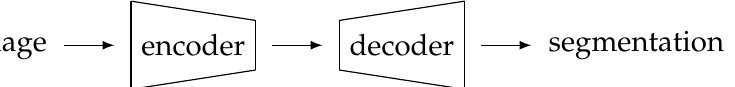
Table 1. Amount of parameters and FLOPs per architecture.